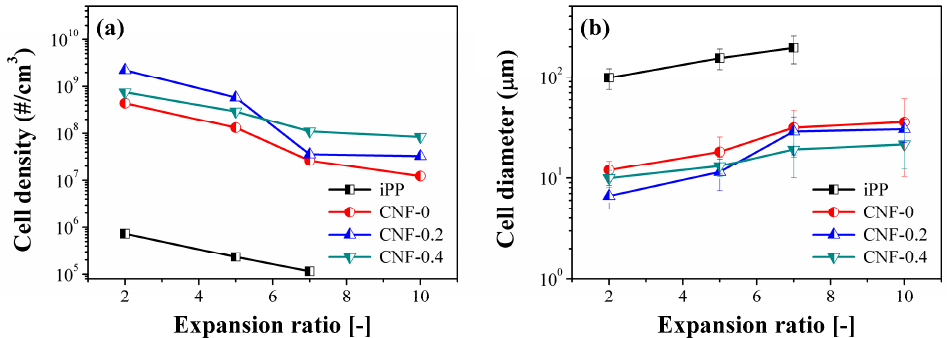
Figure 4. ( a ) Cell density and ( b ) average cell diameter of the neat iPP and polypropylene (PP)/CNF nanocomposite foams as a function of the expansion ratio.